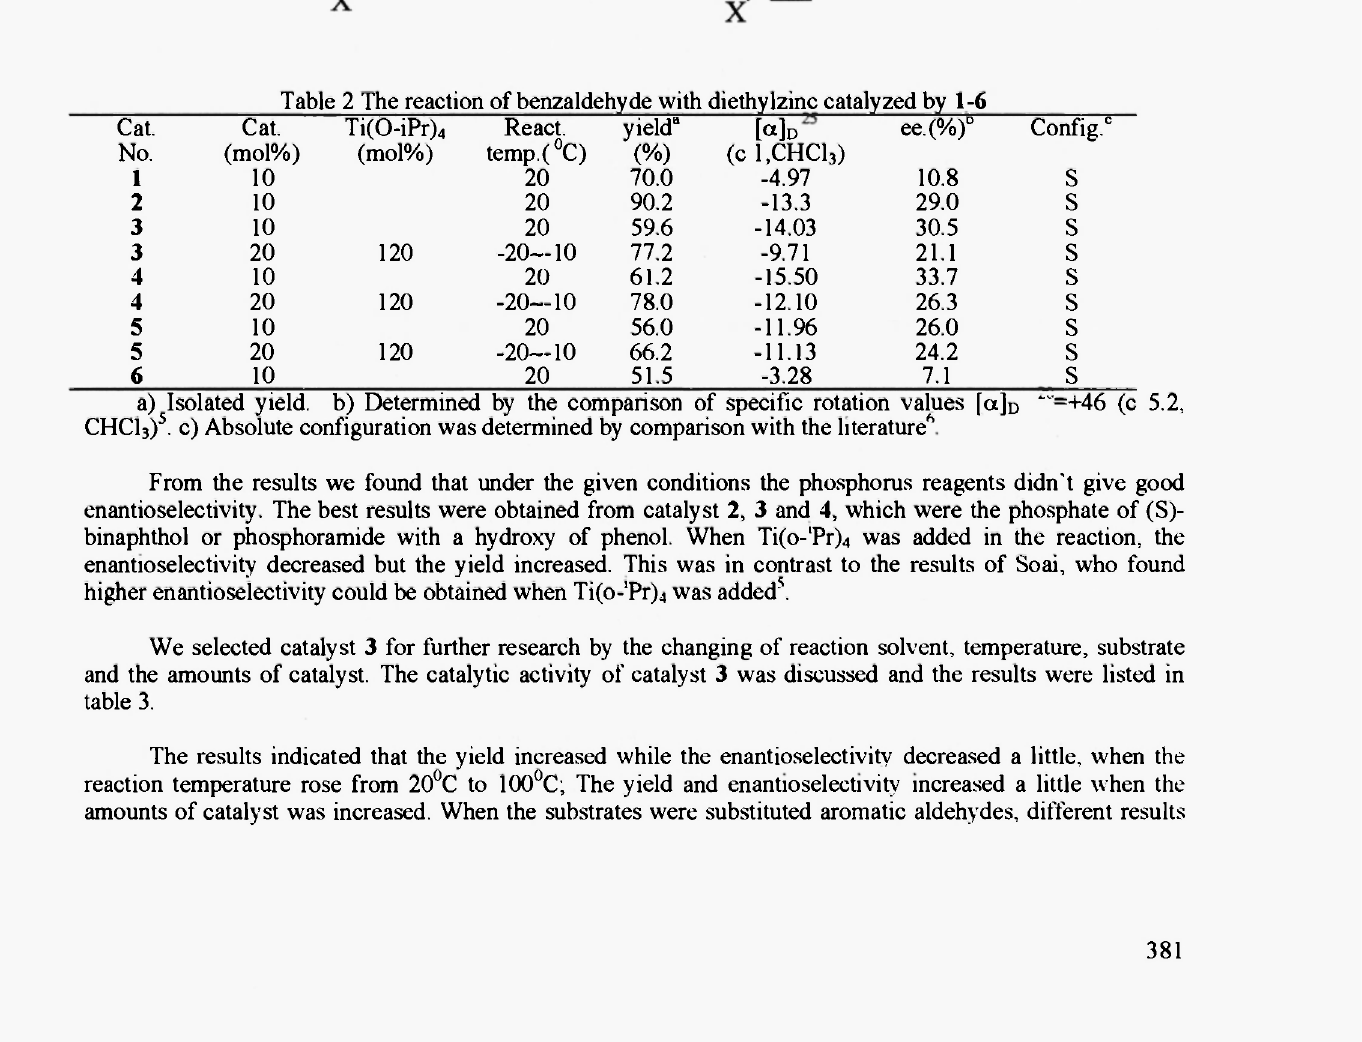
Table 2 The reaction of benzaldehyde with diethylzinc catalyzed by 1-6